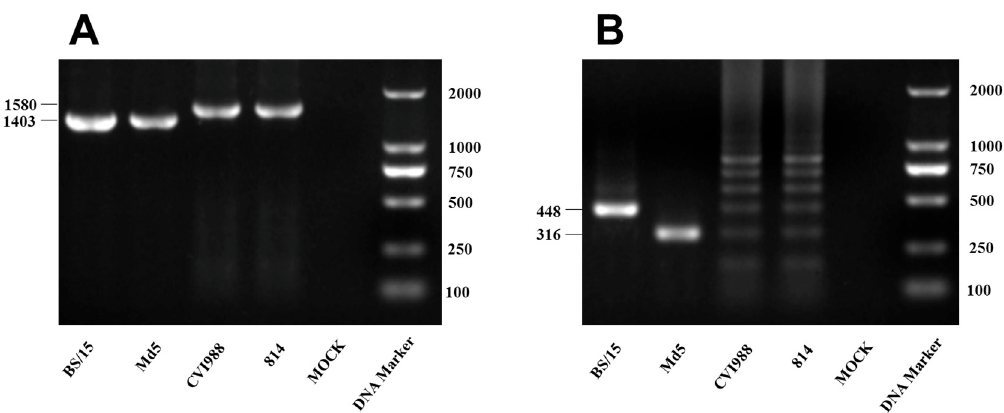
Figure 1. Detection of Marek’s disease virus (MDV) by polymerase chain reaction (PCR). DNA of MDV ‐ infected chicken embryo fibroblasts (CEFs) was used as the template for PCR amplification. ( A ) PCR amplification of the meq gene of MDV. The PCR products of BS/15 and Md5 were 1403 base pair (bp) long, while those of CVI988 and 814 were 1580 bp, as they have a 177 ‐ bp insertion in the meq gene; ( B ) PCR amplification of the 132bpr of MDV. The PCR product of BS/15 132bpr was 448 bp long with a copy number of 3, while the PCR product length for Md5 was 316 bp with a copy number of 2, CVI988 and 814 showed PCR products 316–844 bp long and contained multiple copies of the 132bpr.